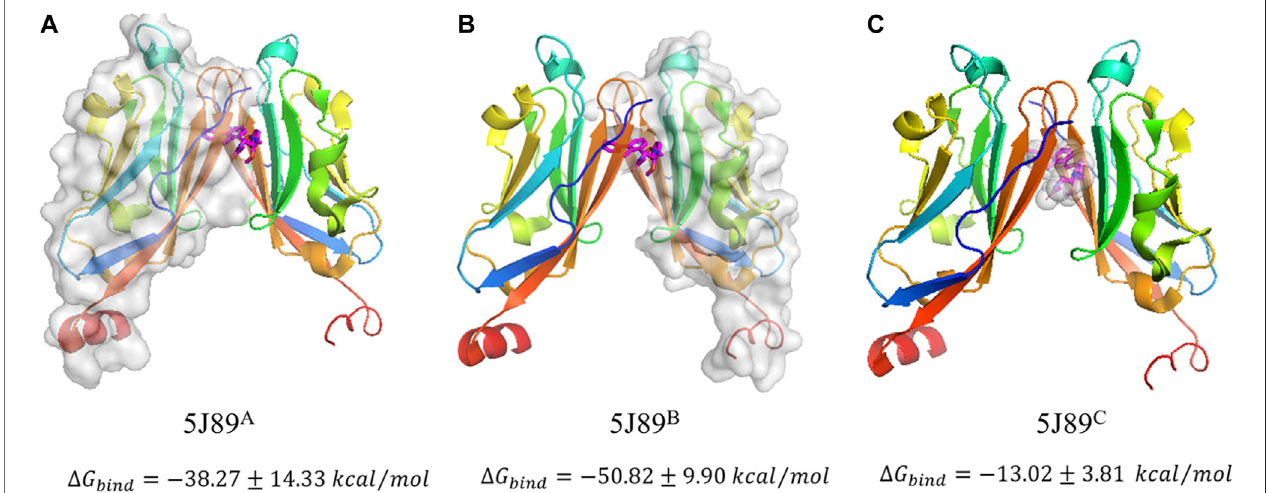
FIGURE 1 | Three kinds of stripping modes of Δ G bind calculation in 5J89 system which are denoted as 5J89 A (A) , 5J89 B (B) and 5J89 C (C) respectively. The gray surfaces represent the stripping interfaces in binding free energy calculations.